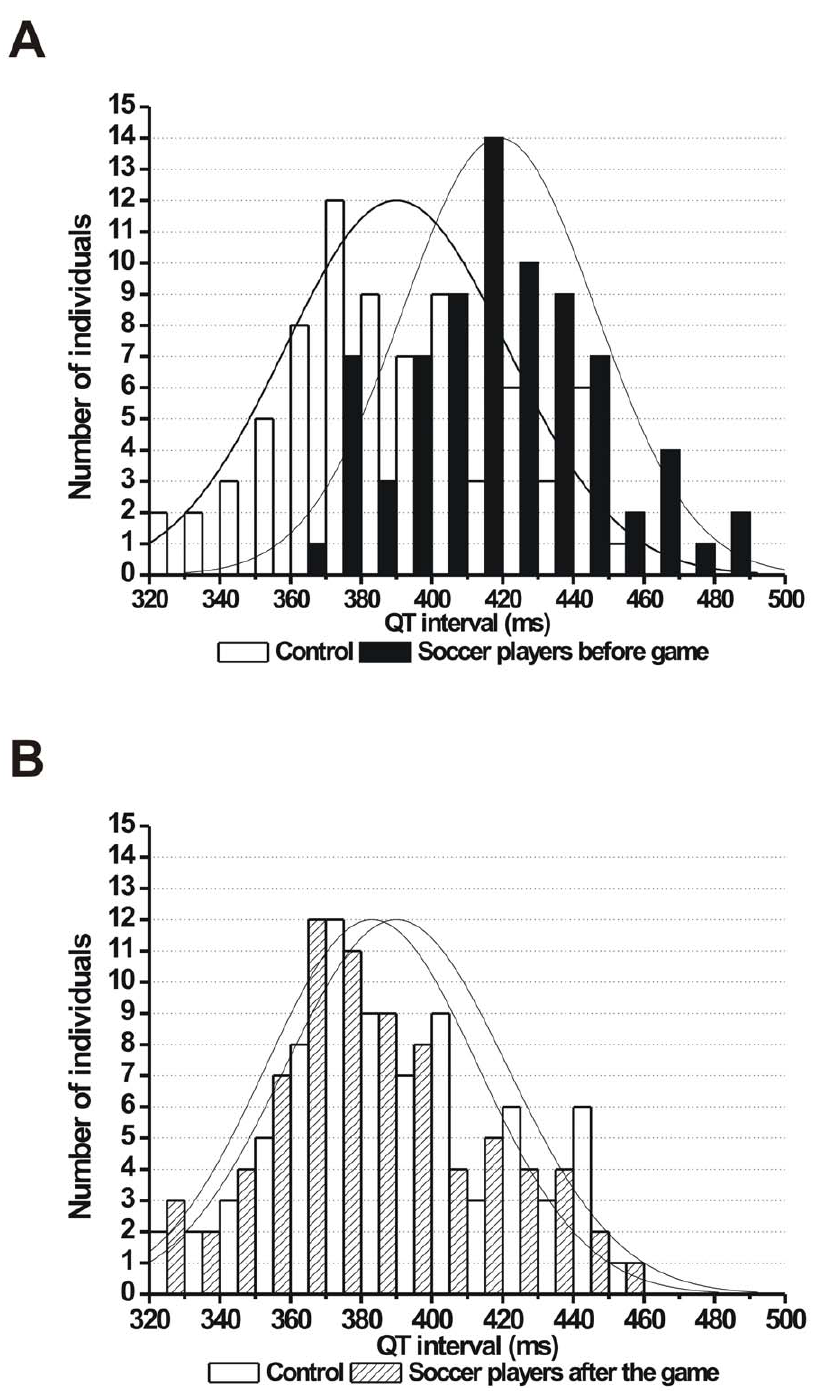
Figure 5. Histograms showing the distribution of the QT interval. ( A ) Controls (empty bars) and soccer players before game (full bars) and ( B ) controls (empty bars) and soccer players after the game (hashed bars). Bin size is 10 ms. (n=76 persons/group).